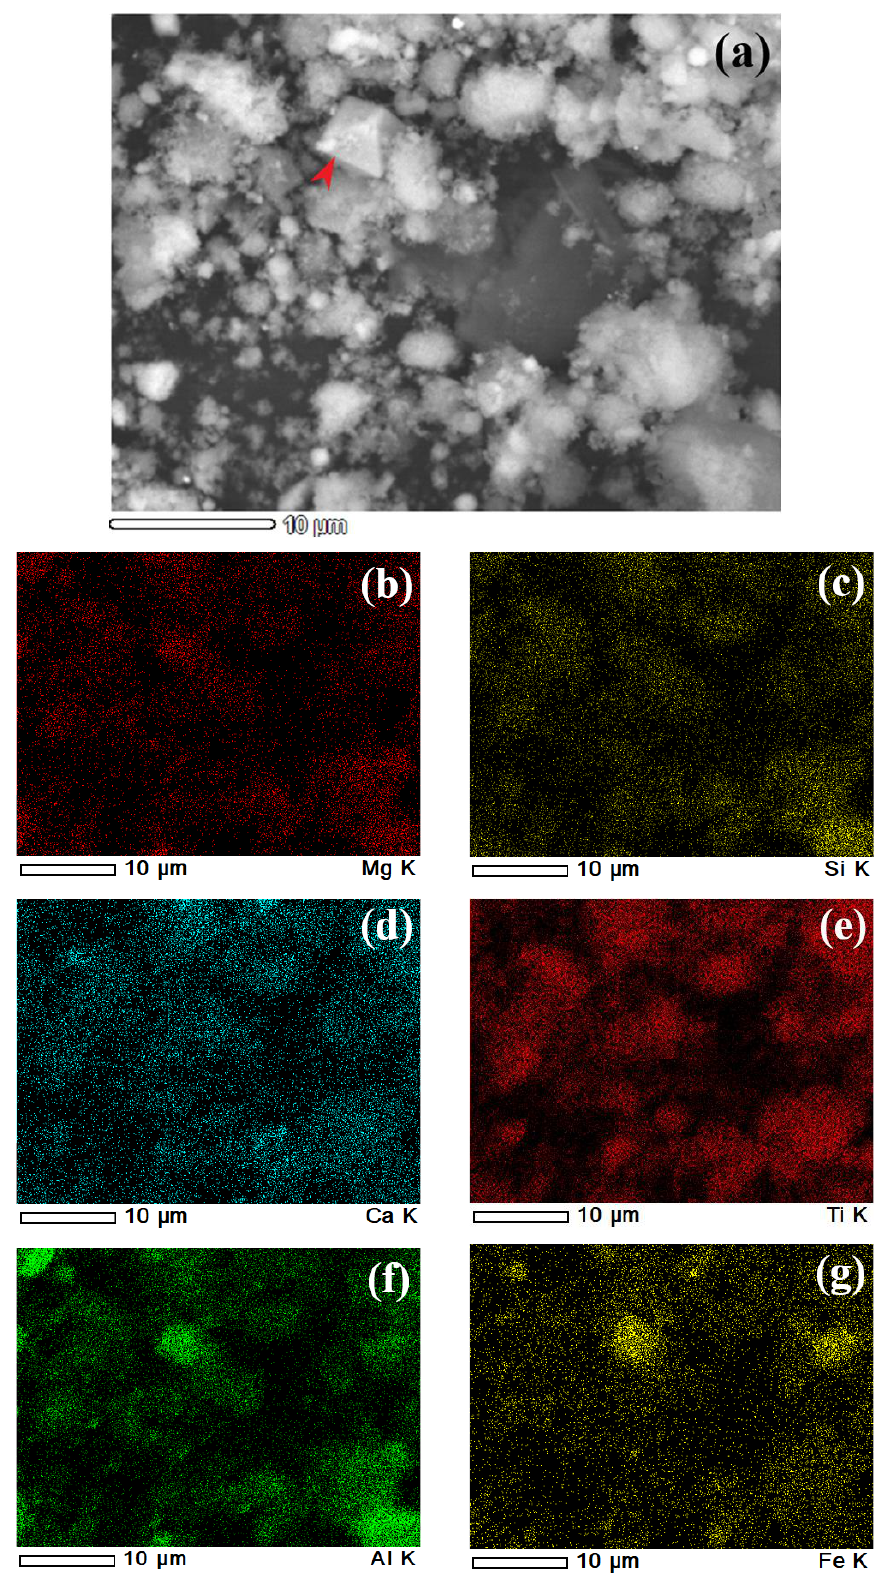
Figure 14. SEM image of the titanium concentrate ( a ) and distribution maps of magnesium ( b ), silicon ( c ), calcium ( d ), titanium ( e ), aluminum ( f ), and iron ( g ).